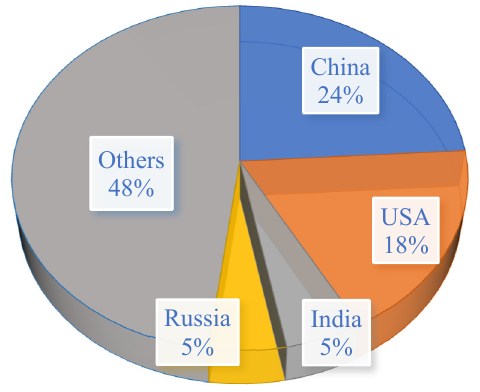
Figure 1. Distribution of carbon dioxide emissions in countries. The dynamics of this parameter in the main emitter countries allow its approximate forecast for the oncoming decades (Figure 2) [4,5]. Since 1976, the USA and Russia’s CO 2 emissions have stayed at a constant level. On the other side, in China and India this parameter has increased by a few times, with the maximal rate in the 21 century beginning because of the rapid increase in industrial activity.